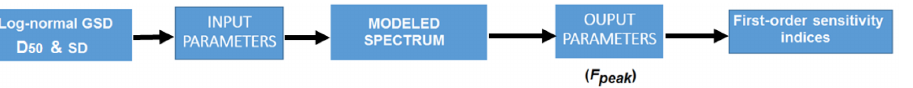
Figure 3. GSA flowchart to compute the first-order sensitivity indices by the FAST method; the spectrum is simulated with Eqs. (7) and (9b), with a log-normal distribution generated using a diameter in the range 1 to 150mm and SD σ in the range 0.01 to 10. The rest of the input parameters are defined in Table 1. From the simulated spectra, the f peak are computed, and finally the first-order sensitivity indices S i are calculated using the FAST method. The results are shown in Table 2.